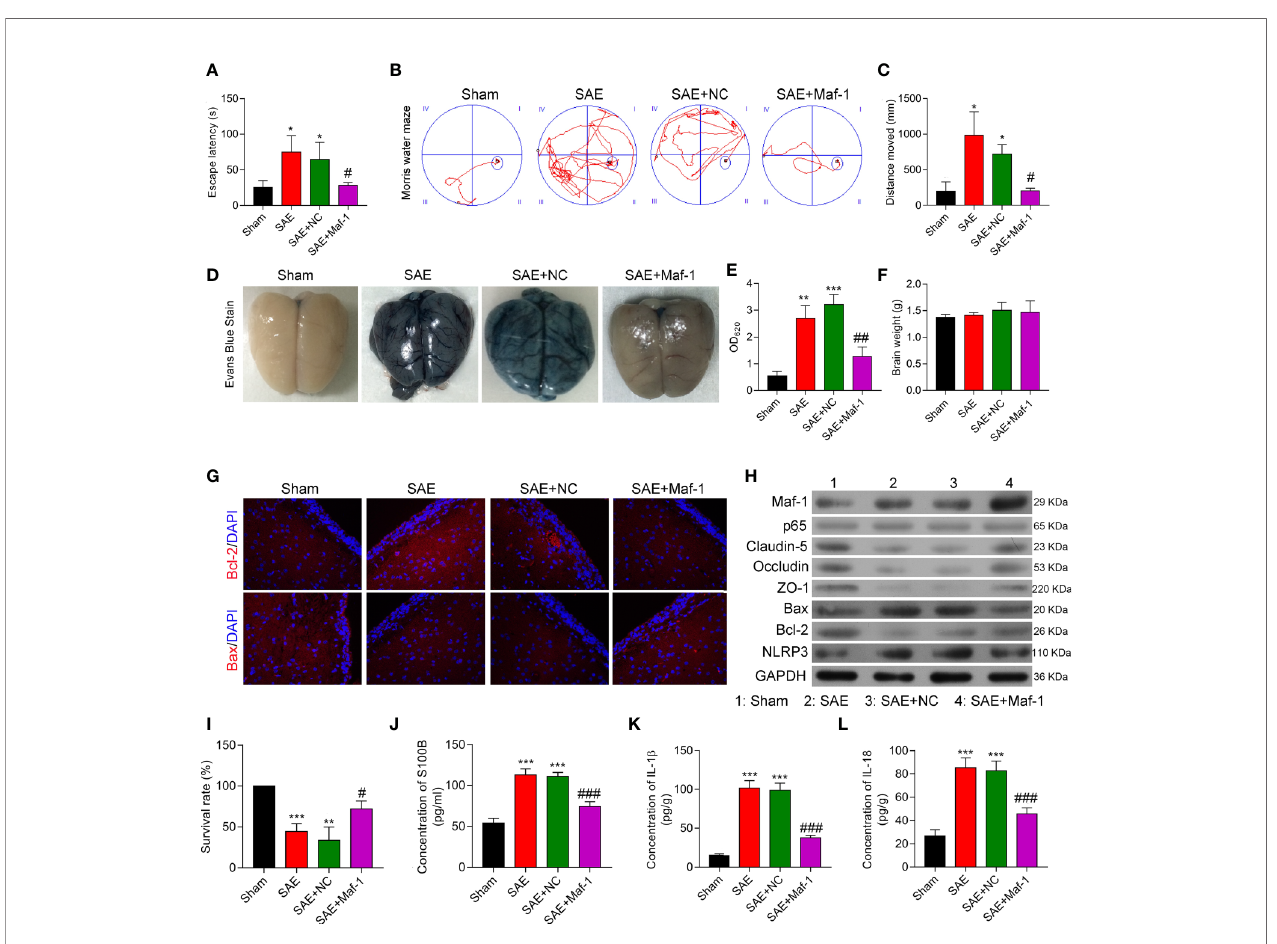
FIGURE 6 | Maf1 improved cognitive impairment and in vivo BBB integrity. (A) Analysis of the escape latency time to the platform in different groups. (B) The swim paths of mice in the MWM test. (C) The distance of crossings over the platform location in the probe trial. (D) Evan ’ s blue dye in the brain tissues. (E) The concentrations of Evan ’ s blue were measured. (F) The weights of the brains. (G) Immuno fl uorescence staining of Bax and Bcl-2 in brain tissues. (H) Western blot results for levels of Maf1, p65, Claudin-5, Occludin, ZO-1, Bax, Bcl-2, and NLRP3. (I) The survival rate of rats in the different groups was calculated. (J – L) Cerebral cortex tissue was collected and analyzed for S100B (J) , IL-1 b (K) , and IL-18 (L) via ELISA. Results are expressed as the mean value ± SD of data obtained from three separate experiments. * p < 0.05, ** p < 0.01 and *** p < 0.001, compared with Sham; #, p < 0.05, ## p < 0.01 and ### p < 0.001, compared with SAE +